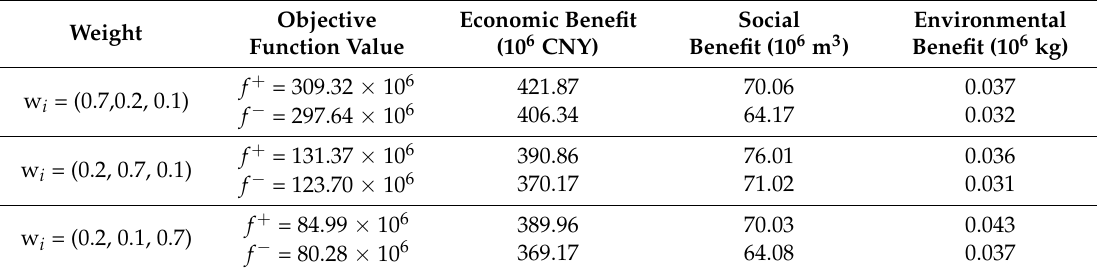
Table 11. Results of objective function values by the weighted sum method (WSM)